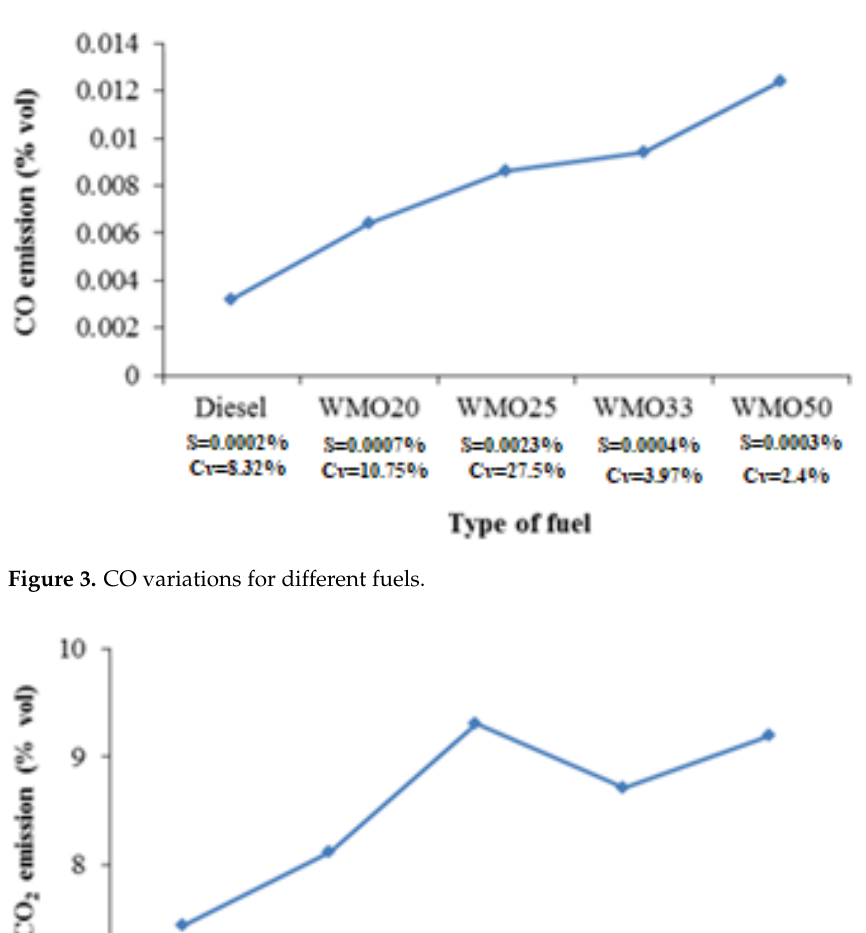
Figure 4. CO 2 variations for different fuels.